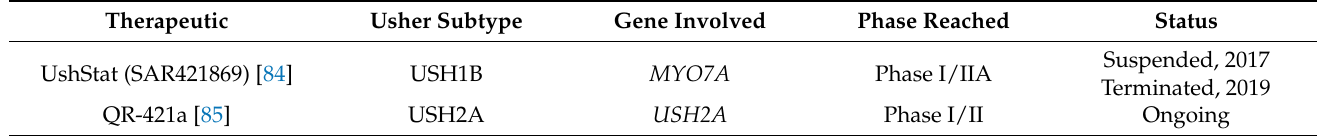
Table 2. Gene therapy for retinitis